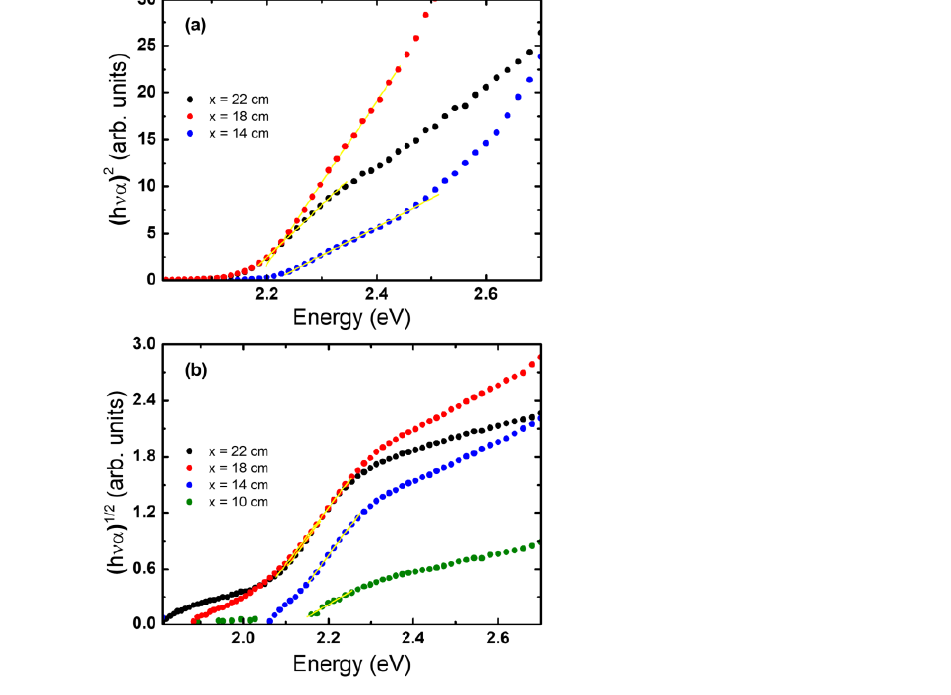
Figure 6. Direct ( a ) and indirect ( b ) optical bandgap of the hematite films. The Tauc plot corresponds to samples prepared at the positions of 10, 14, 18, and 22 cm. Table 1. Optical bandgap values estimated assuming direct and indirect optical